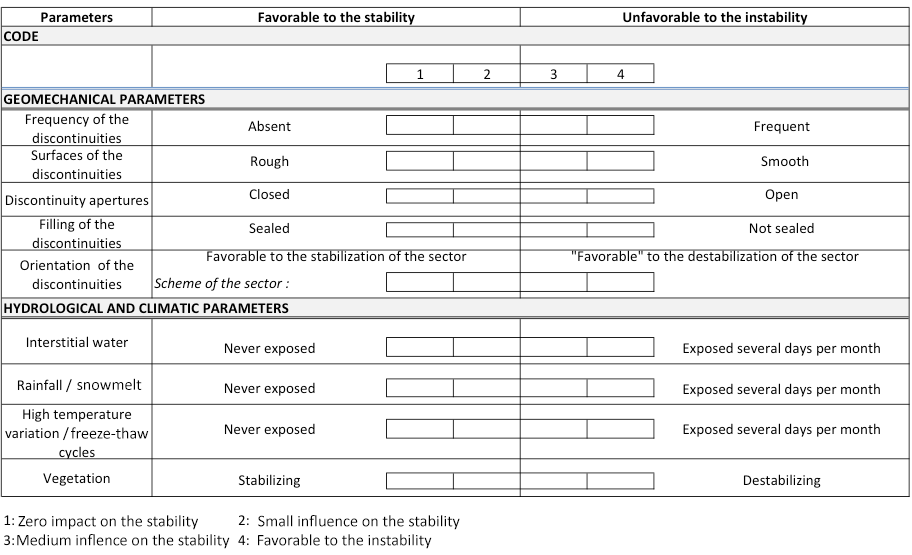
Figure 3. Quantification of LPC